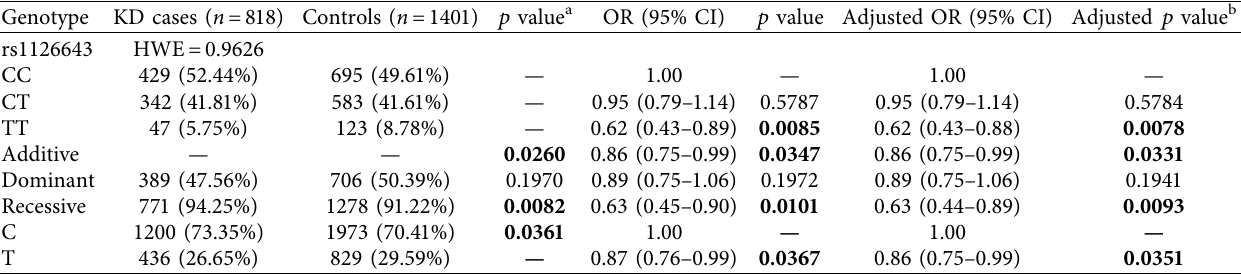
Table 3: Genotype frequency distribution of platelet glycoprotein Ia/IIa C807T (rs1126643) polymorphism in Kawasaki disease cases and healthy